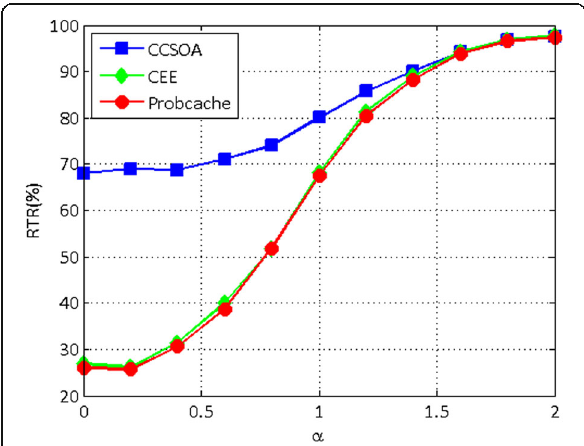
Fig. 33 The impact of Γ to RTR with different network Fig. 34 The impact of Zipf parameter to RTR to MBS in